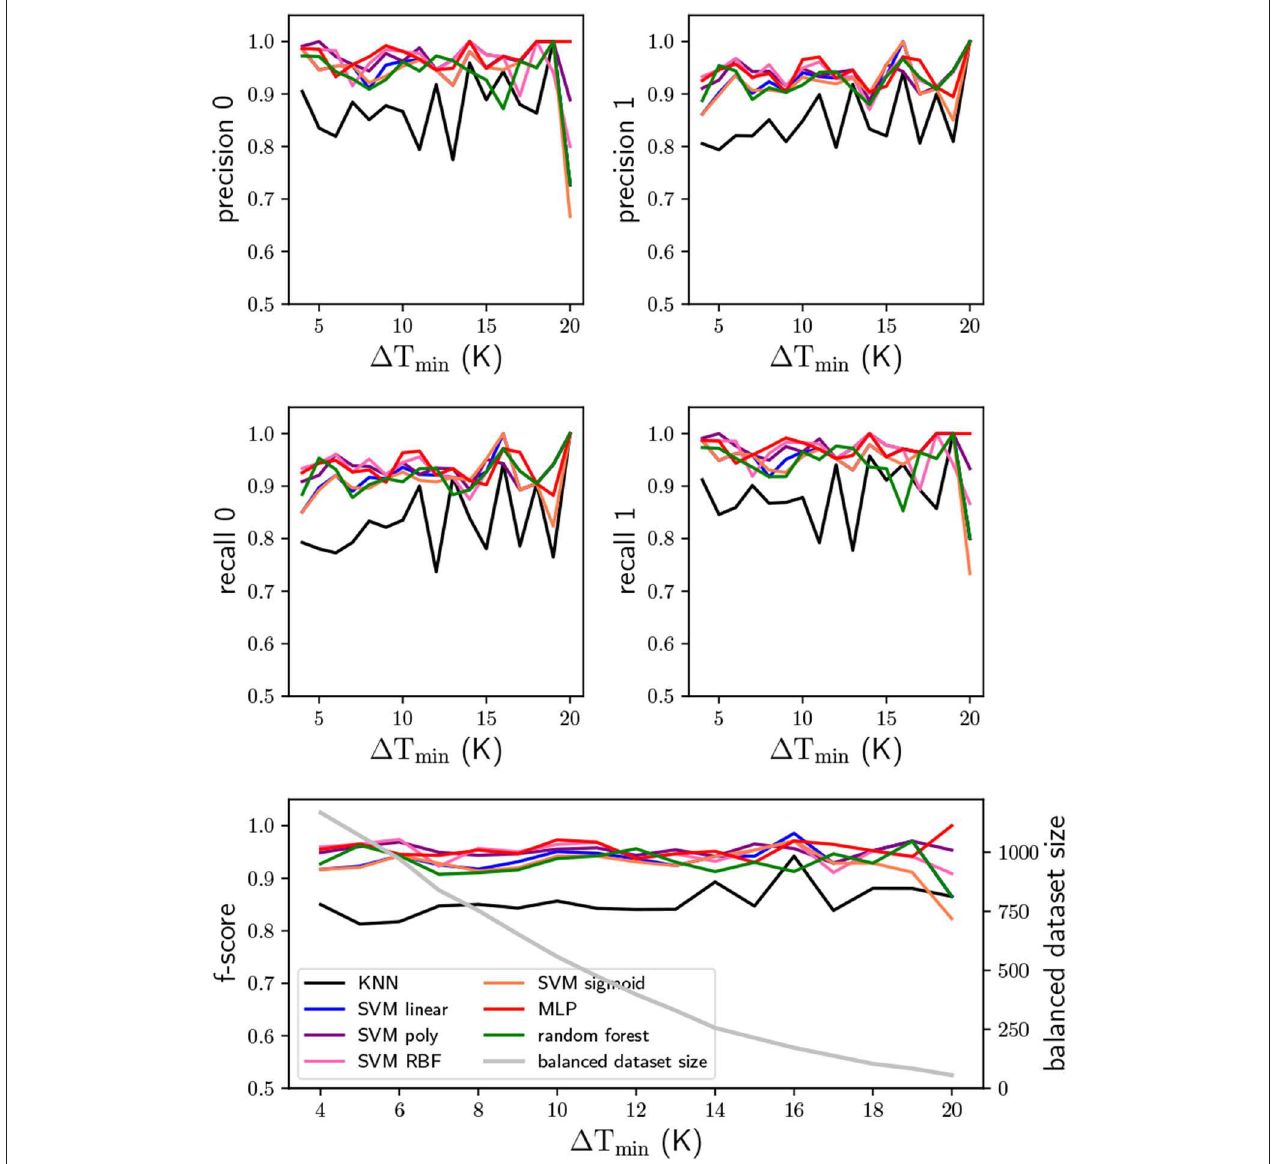
FIGURE 5 | Precision and recall of the temperature span from 4K to 20K, for the two possibilities of the G variable (0 and 1), and the respective f-score average. In the f-score plot it is also shown the balanced dataset